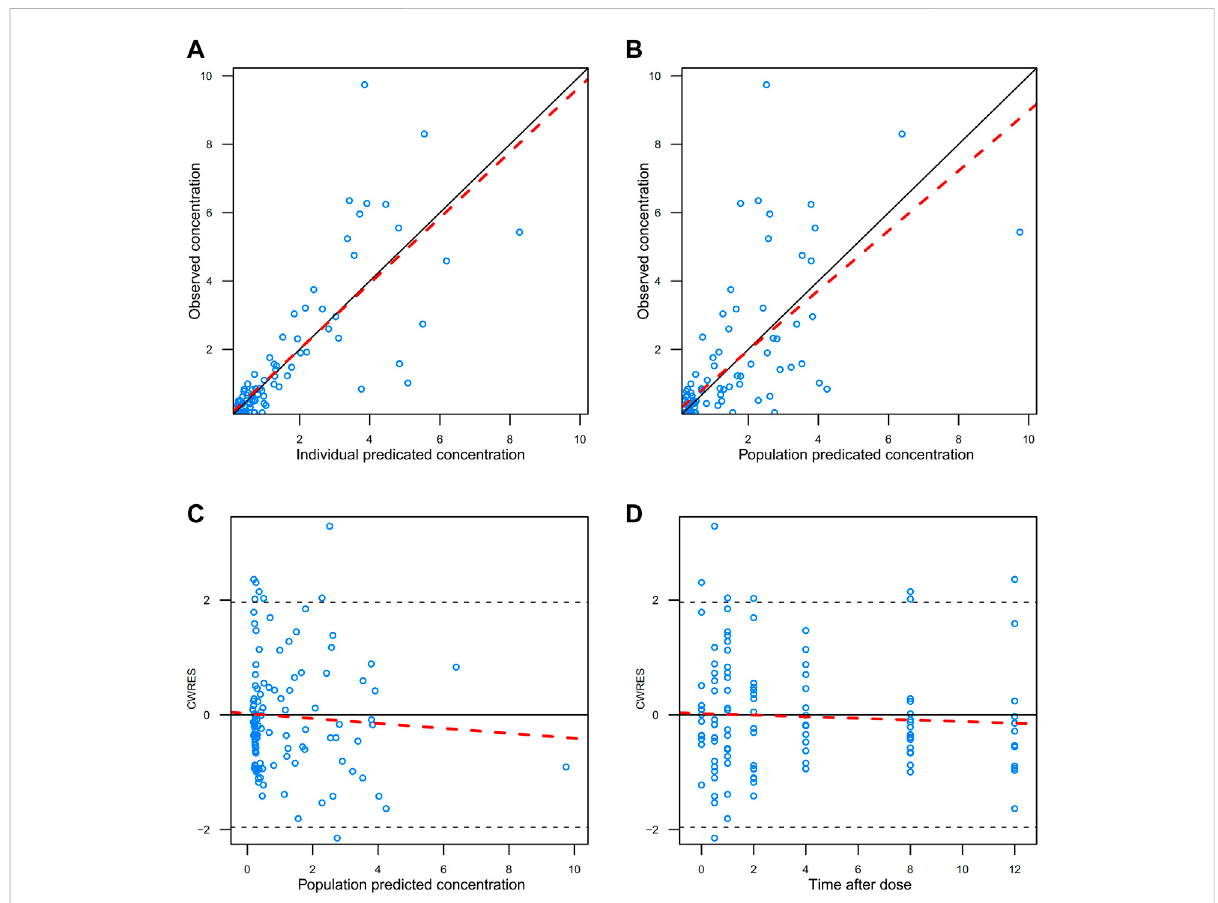
FIGURE 3 GOFs diagnosis diagram of the fi nal model. (A) observed value vs. individual predicted value; (B) observed value vs. predicted population value; (C) conditionalweightresidualsvs.populationpredictedvalues; (D) conditionalweightedresidualsvs.timeafterdose.Thereddottedlinerepresents trendline, while the solid black line represents reference